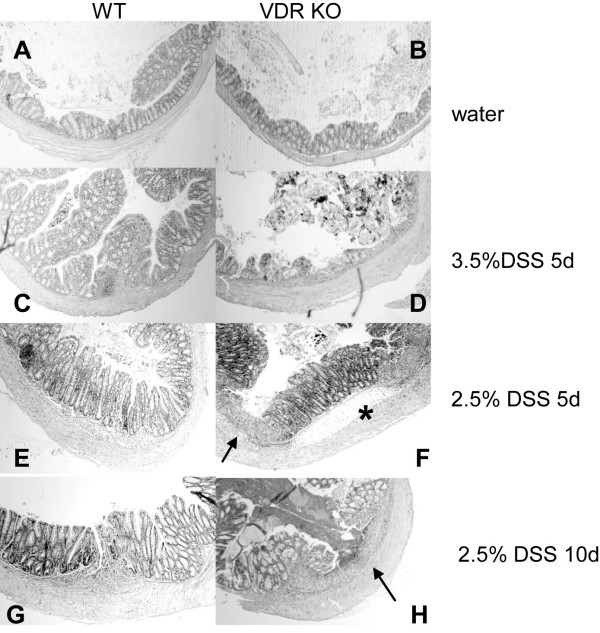
Colitis development following DSS administration. Representative sections and histological assessment of colonic samples from A) WT and B) VDR KO mice receiving water; C) WT and D) VDR KO mice 5 days after receiving 3.5% DSS; E) WT and F) VDR KO mice 5 days after 2.5% DSS; G) WT and H) VDR KO mice 10 days after 2.5% DSS. Edema (asterisk), cellular inflammation in all layers (arrows).